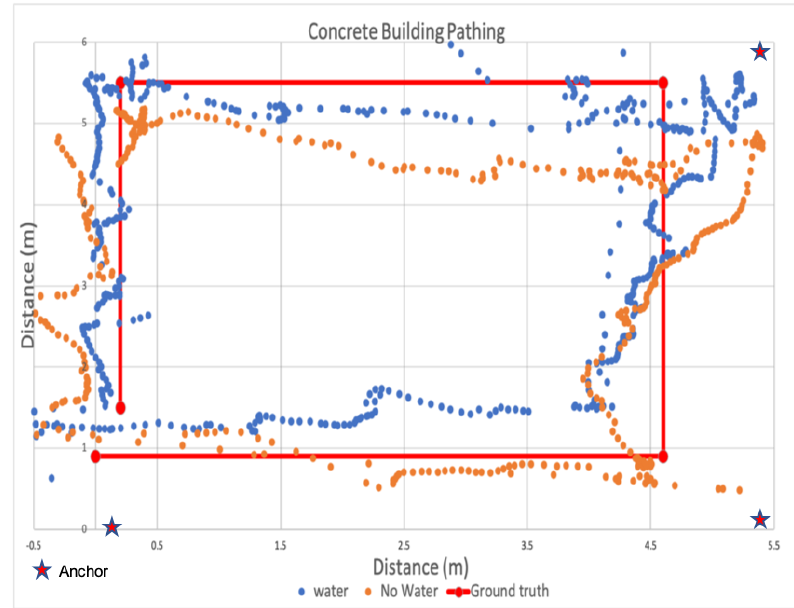
Figure 19. UWB Path testing at Fire Training